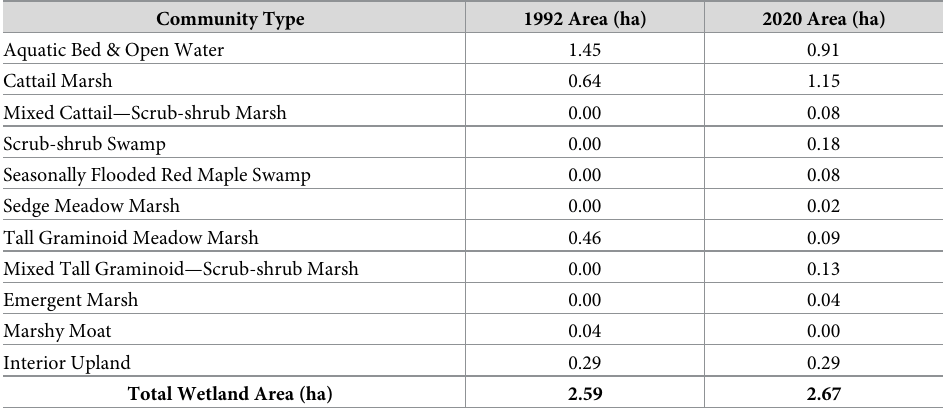
were not recorded in the first two floral surveys. The combination of both forms of tall gram- minoid meadow marshes still represent only 47% of the original area. The increase in shrub and tree canopy cover led to the development of four new wetland community types and a widspread presence of woody vegetation at the site over time. The combination of all communities with a shrub and tree canopy element would represent the third largest wetland community of 0.47 ha, a major increase since 1992. Previous floral studies did not mention any notable extent of shrub and tree cover. Alnus incana and Frangula alnus shrubs have expanded into the wetland, especially into cattail marsh demonstrated by the pres- ence of the mixed cattail–scrub-shrub marshes. The narrow mixed tall graminoid—scrub- shrub marshes with C . stricta understory has replaced prior interior uplands or Phalaris-Juncus meadow marshes. The southestern patch of scrub-shrub swamp has formed on a prior upland island, potentially driven by the creation of a inlet channel by beavers. Lastly, the red maple Table 6. The average mean cover and plot frequency of understory species in the cattail marsh and aquatic bed communities of the 2020 floristic survey of Quarry Pond. Species Visual Cover Plot Frequency (%) Cattail Marsh Typha latifolia 15.3 ± 1.2 97 Carex sp. 1.6 ± 0.8 1.2 ± 0.6 Aquatic Bed Nuphar variegata 16.5 ± 4.2 59 Brasenia schreberi 15.4 ± 4.4 56 Utricularia macrorhiza 5.5 ± 1.7 59 Potamogeton sp. 2.0 ± 0.79 44 Potamogeton natans 1.4 ± 0.5 30 Visual cover is reported as mean ± standard